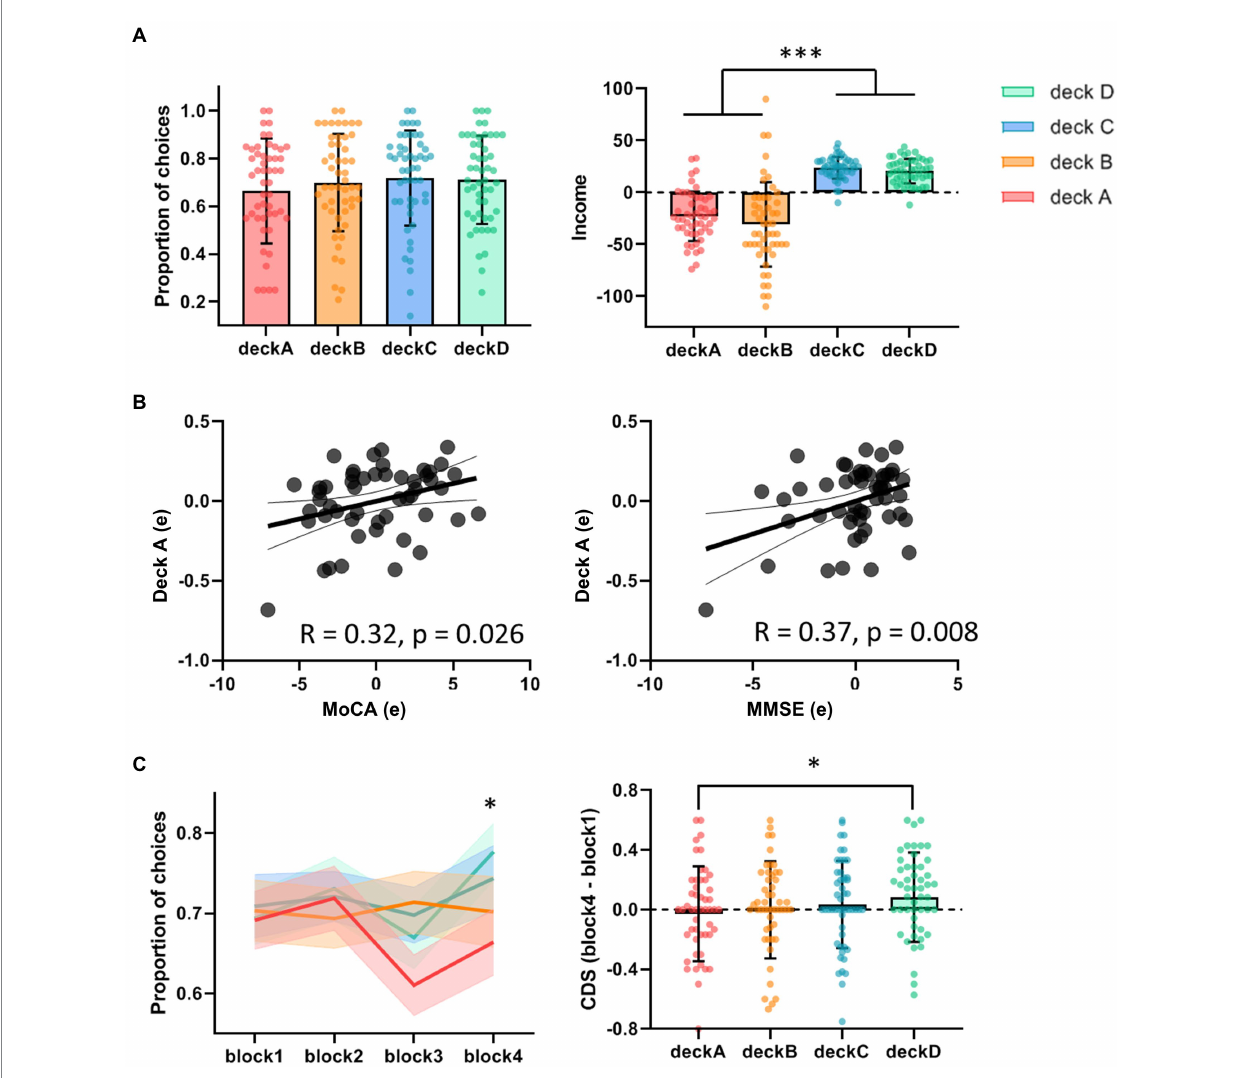
FIGURE 2 Task performance in the IGT. (A) The proportions of deck selection showed no significant difference across the four decks. The total incomes were significantly higher in advantageous decks versus disadvantageous decks. (B) Partial correlations showed positive correlations between deck A choice and MoCA/MMSE, controlled for age and education. (C) In the block analyses, older adults tended to avoid choosing deck A, showing significant difference of CDS between deck A and deck D. * p < 0.05; *** p <